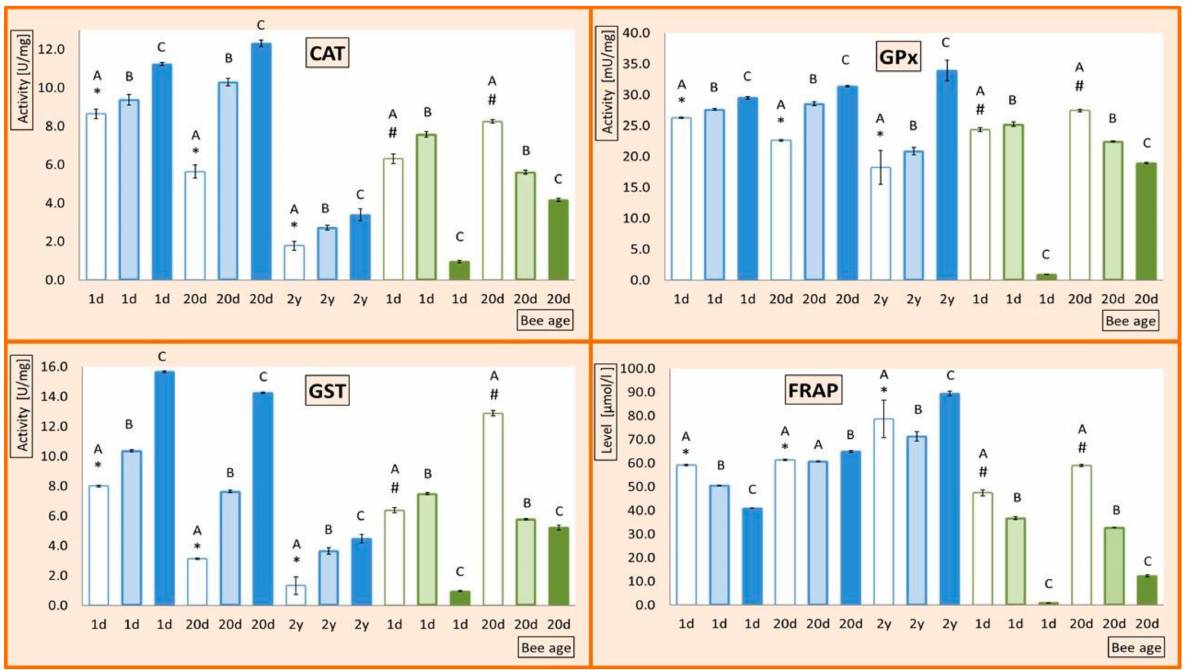
Figure 2. Mean activities (mean ± SD) of catalase ( CAT ), glutathione peroxidase ( GPx ), glutathione S-transferase ( GST ), and the level of the ferric reducing total antioxidant potential ( FRAP ). Error bars indicate SD. 1-day-old bees (1d), 20-day-old bees (20d), and 2-year-old bees (2y); queens ( blue bars ); workers ( green bars ); bee diet contains 0 ppm ( transparent bars ), 5 ppm (light-shadowed bars), and 200 ppm (dark-shadowed bars) imidacloprid. Different capital letters indicate that differences between the means (diets) nested within a particular age and caste are significant (ANOVA + LSD; p < 0.01). Values marked with # differ significantly from each other. Values marked with asterisk differ significantly from each